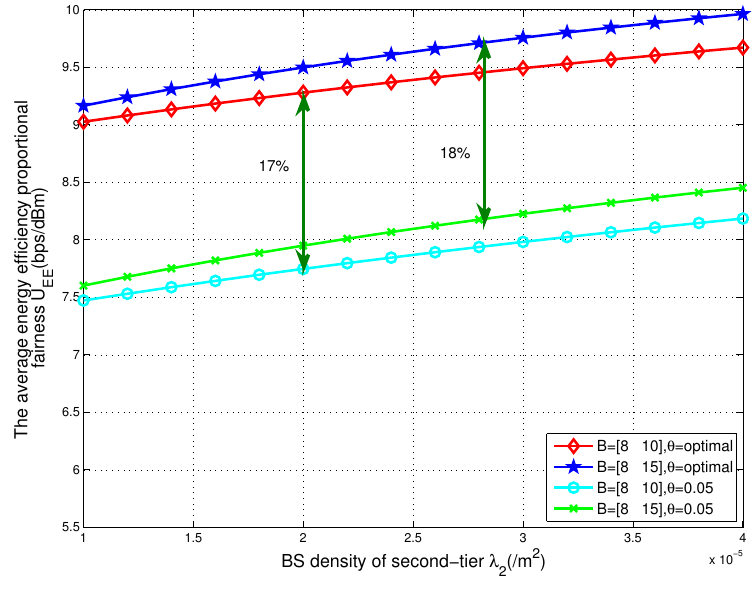
Figure 5. The energy efficiency proportional fairness of total two-tier heterogeneous WPCNs with respect to the density of BSs in tier 2 for different values of the tier-2 cell association bias